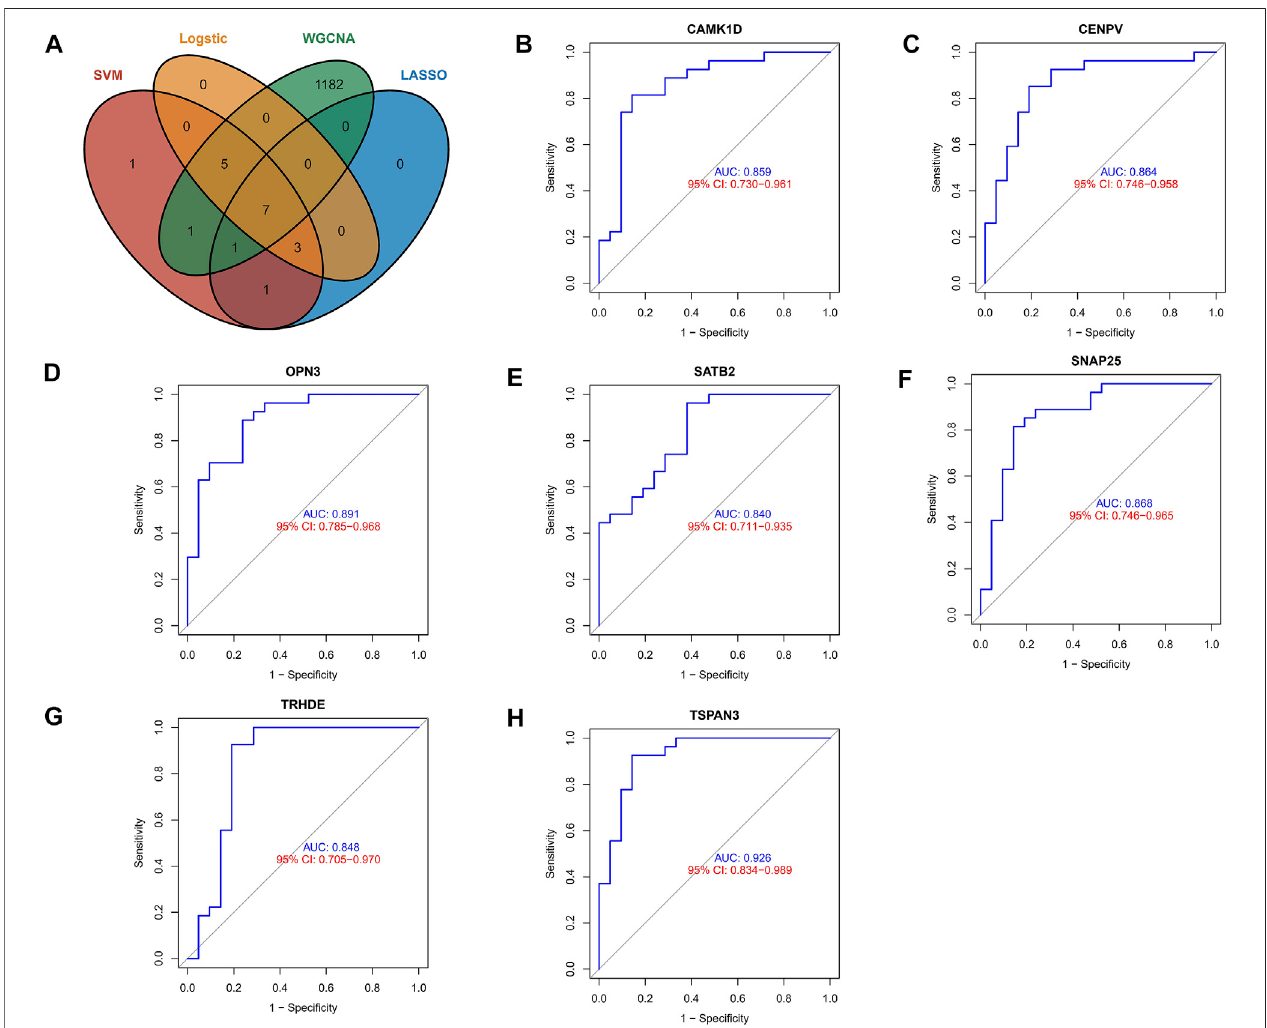
FIGURE 4 | Exploring the predictive value of biomarkers. (A) Cross-tabulation of relevant genes from WGCNA, LASSO, Logistic, and machine learning to identify candidate genes. (B – H) ROC analysis of the aforementioned genes.